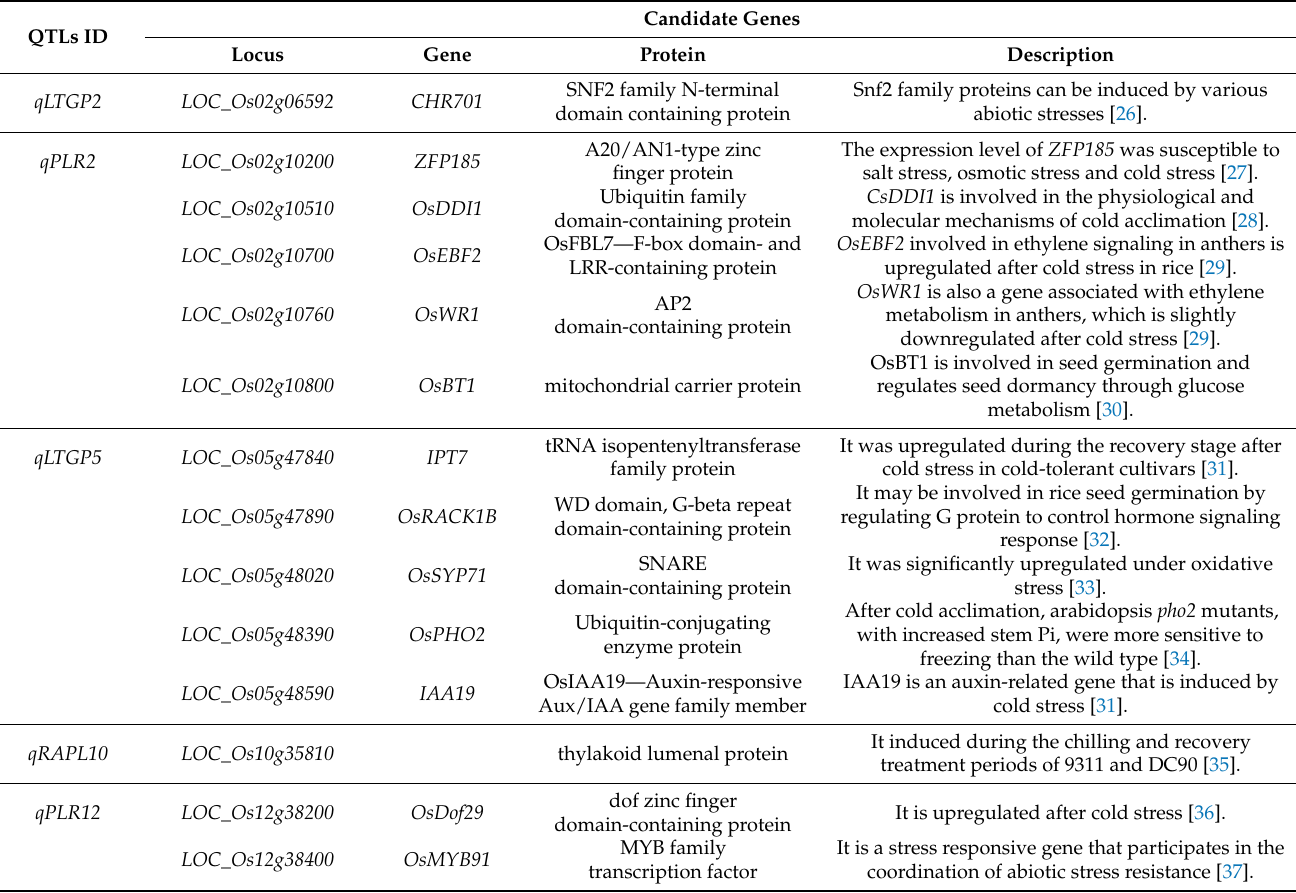
Table 3. Candidate genes of the five